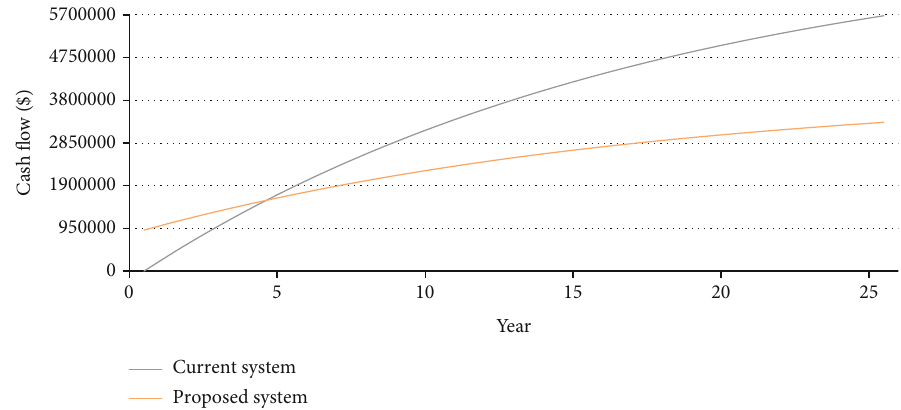
Figure 42: Cumulative cash fl ows over the project lifetime for the current and proposed systems for South Sudan.